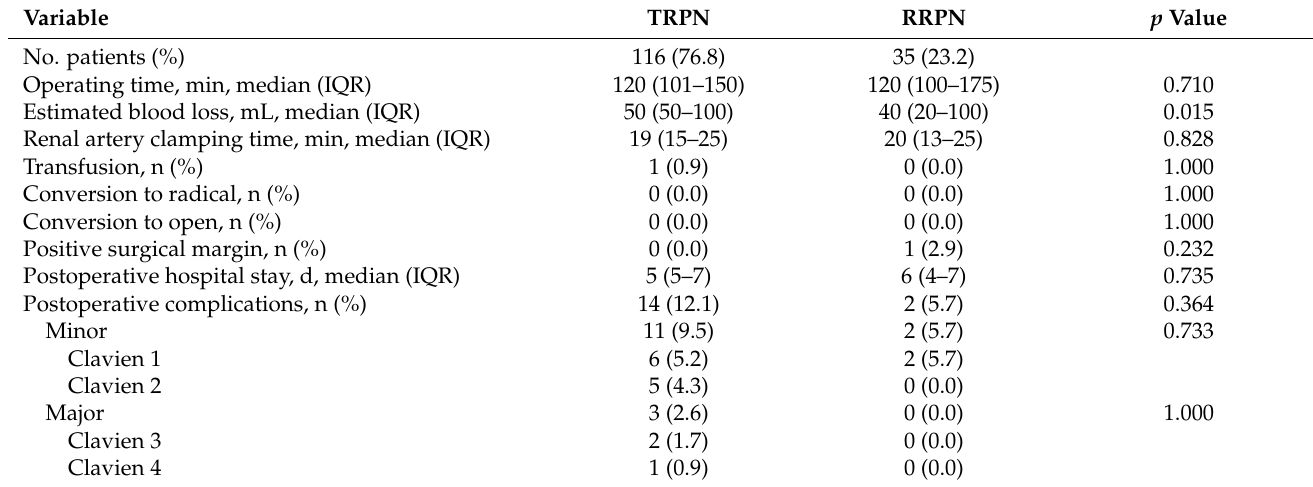
Table 2. Perioperative outcomes.